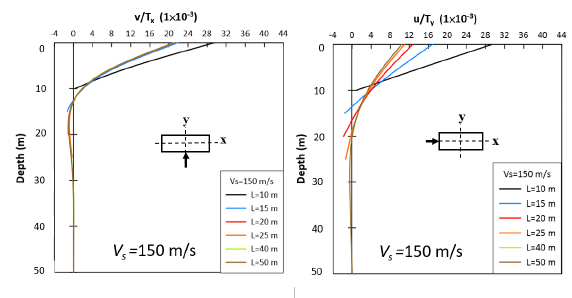
Fig. 17. Normalized deflections of the barrette in sands